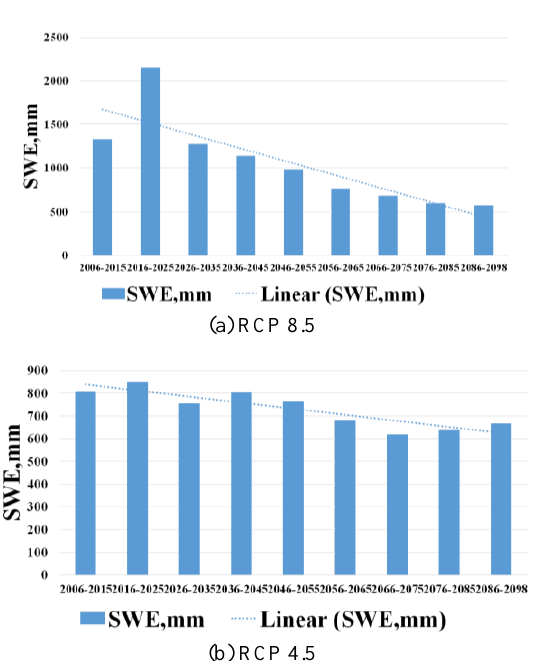
Figure 9. Change in snow melt under each scenario for Beas Basin